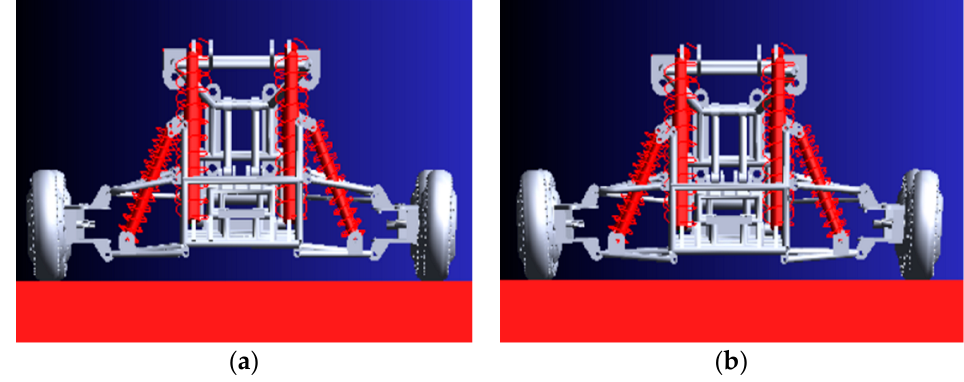
Figure 4. Vehicle load comparison chart. ( a ) The body is not loaded, ( b ) The body is loaded.